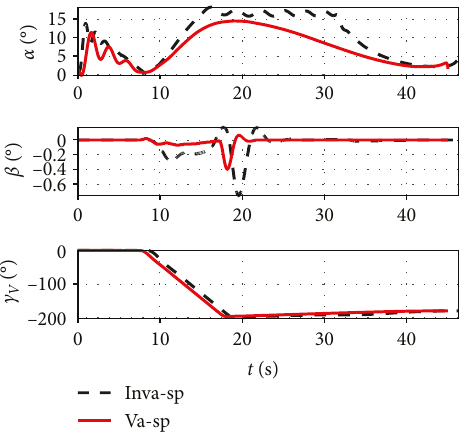
Figure 15: Curve representing the morphing rate. Inva_sp: invariable span; Va-sp: variable